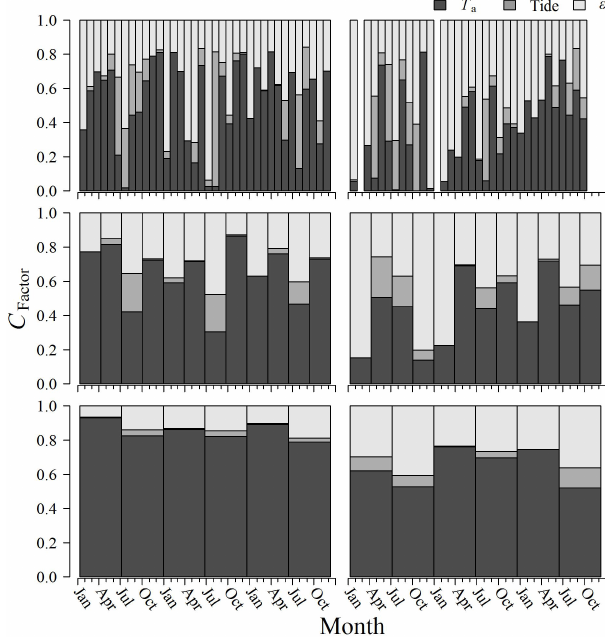
Fig. 3. Variation of C Factor (relative importance of environmental factor) on monthly (top), seasonal (middle), and semiannual (bot- tom) scales. Left side is for CMW1, and right side is for CMW3. Each bin is defined by the lunar calendar, but ticks on the horizontal axes reflect the Gregorian